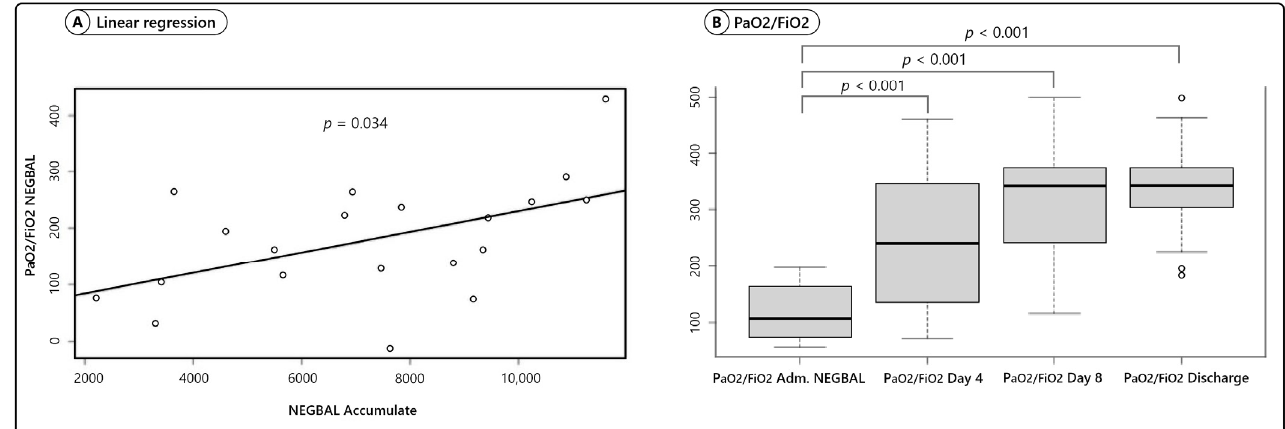
Figure 1. PAFI evolution during NEGBAL approach. ( A ) Scatter plot and regression line for PAFIBAL onto NEGBAL. ( B ) Boxplot for the PaO2/FiO2 ratio on the day of admission, day 4, day 8, and on day of discharge.